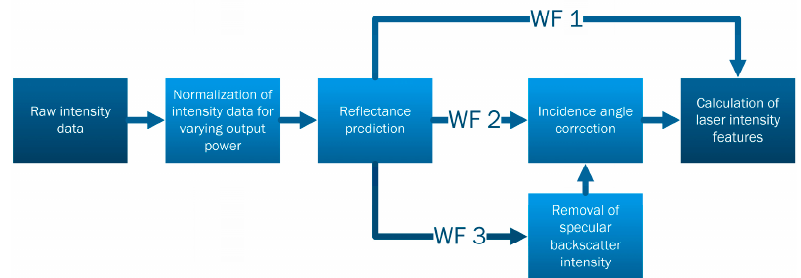
Figure 2. The different processing workflows (WFs) of the intensity data correction. The acronyms are WF 1: Intensity calibration; WF 2: Intensity calibration & incidence angle correction; WF 3: Intensity calibration, incidence angle correction & removal of specular backscatter intensity.